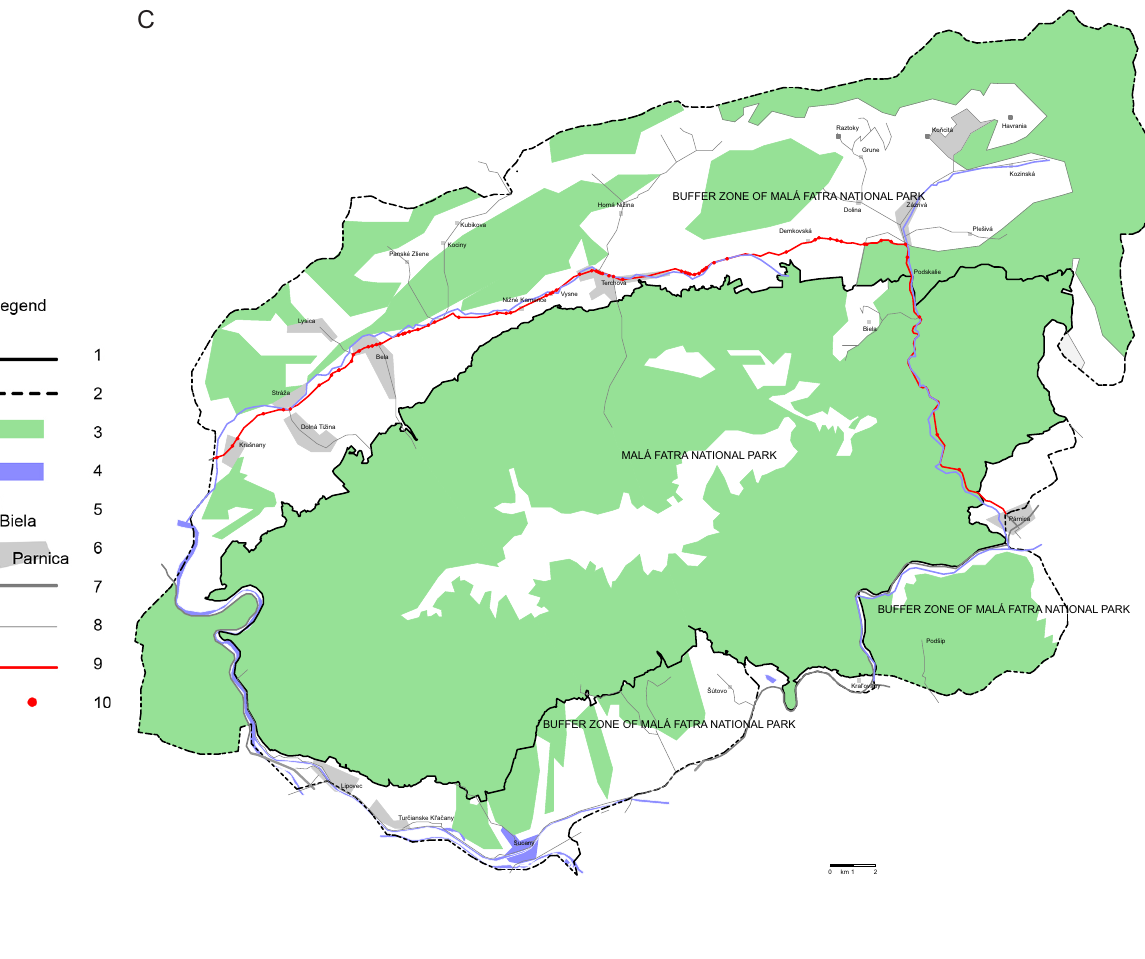
Fig. 2C. Location of advertisements along main roads in the analysed parks: C – Malá Fatra National Park (NPMF). 1 – park area border; 2 – buffer zone border; 3 – forests; 4 – water bodies; 5 – villages; 6 – built- up areas; 7 – main road; 8 – secondary road; 9 – road covered by research; 10 – approximate location of advertisements’ aggregations Source: own